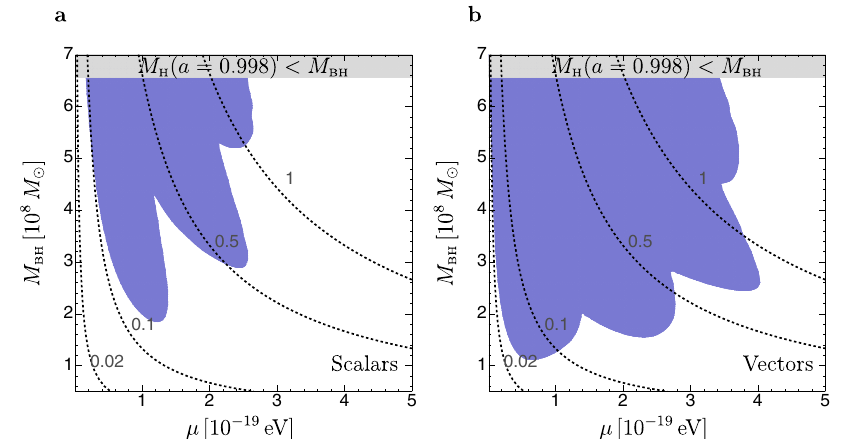
where the BH mass exceeds the Hills mass for a Sun-like star and a SMBH spin a =0.998. Dashed black: values of the gravitational coupling α ≡ GM BH μ . The spin dependence of the Hills mass is taken from ref.